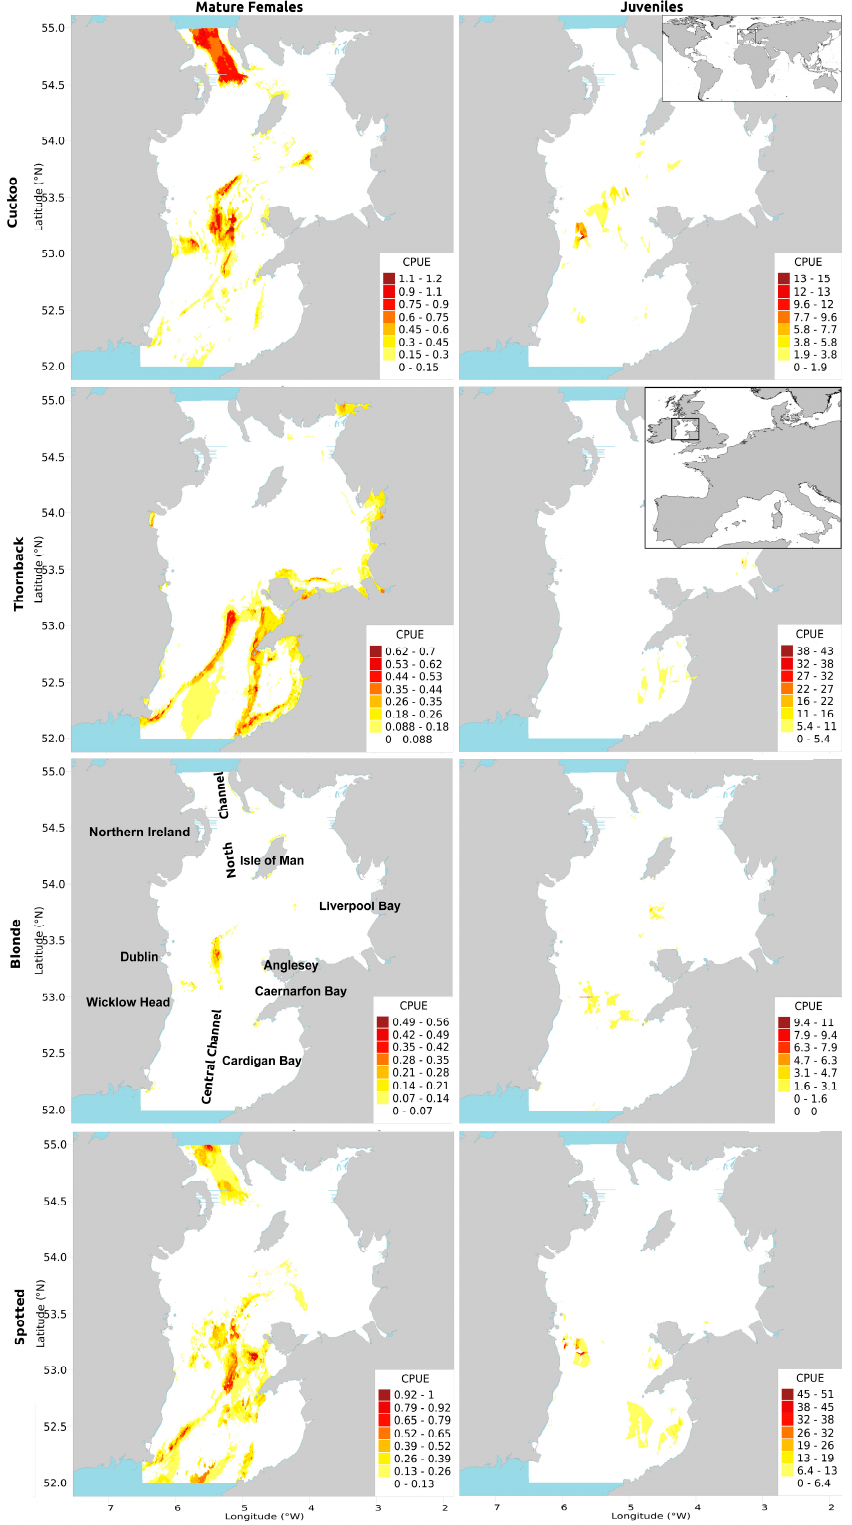
Figure 2. Model predicted CPUE (numbers per hour) of mature female rays based on environmental variables and fishing pressure (left column) and juvenile rays based on environmental variables, fishing pressure, direct removal of eggcases by scallop dredges, whelk LPUE, and CPUE of suitably sized cod, haddock, plaice, whiting, common skate and blonde ray (right